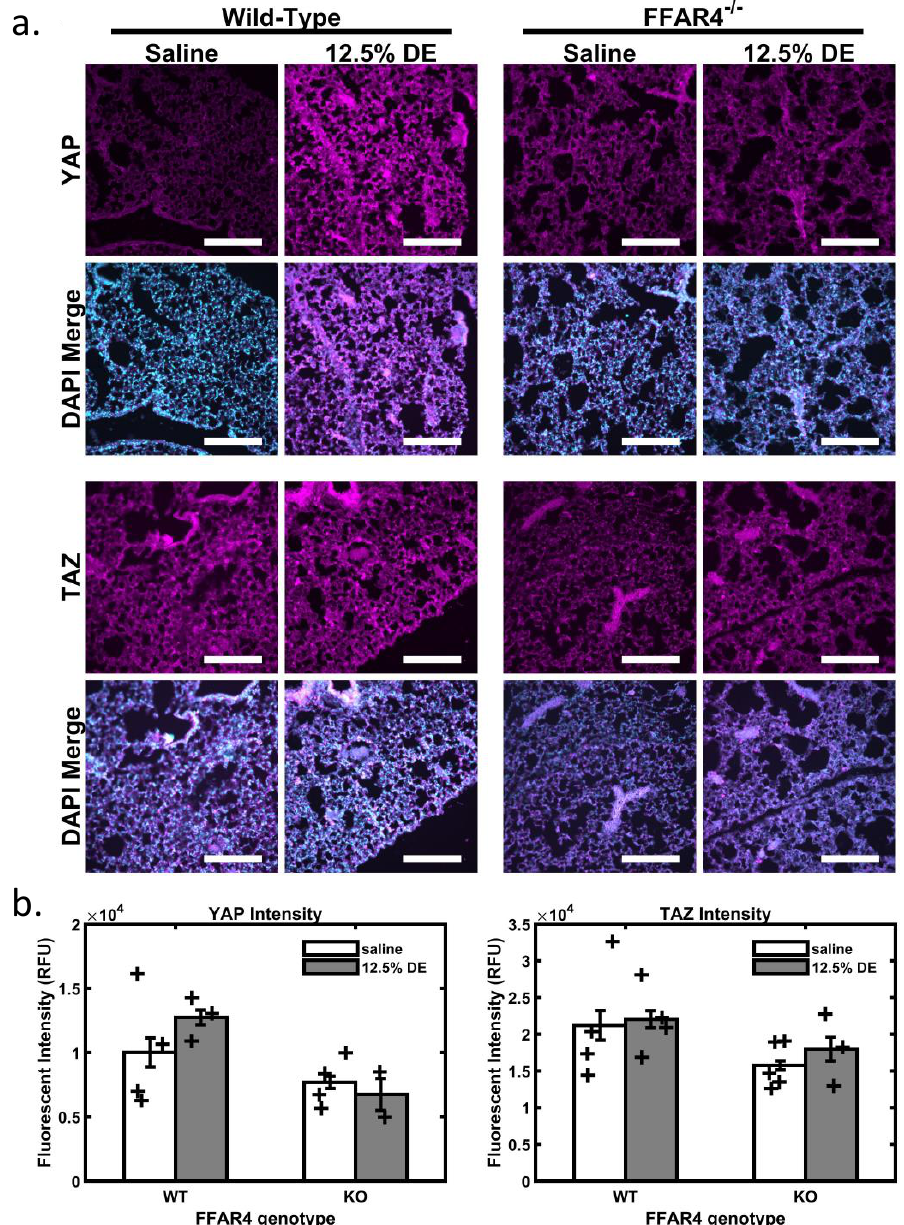
Fig 4. Lack of Ffar4 and reduced YAP signal in lung immunofluorescence